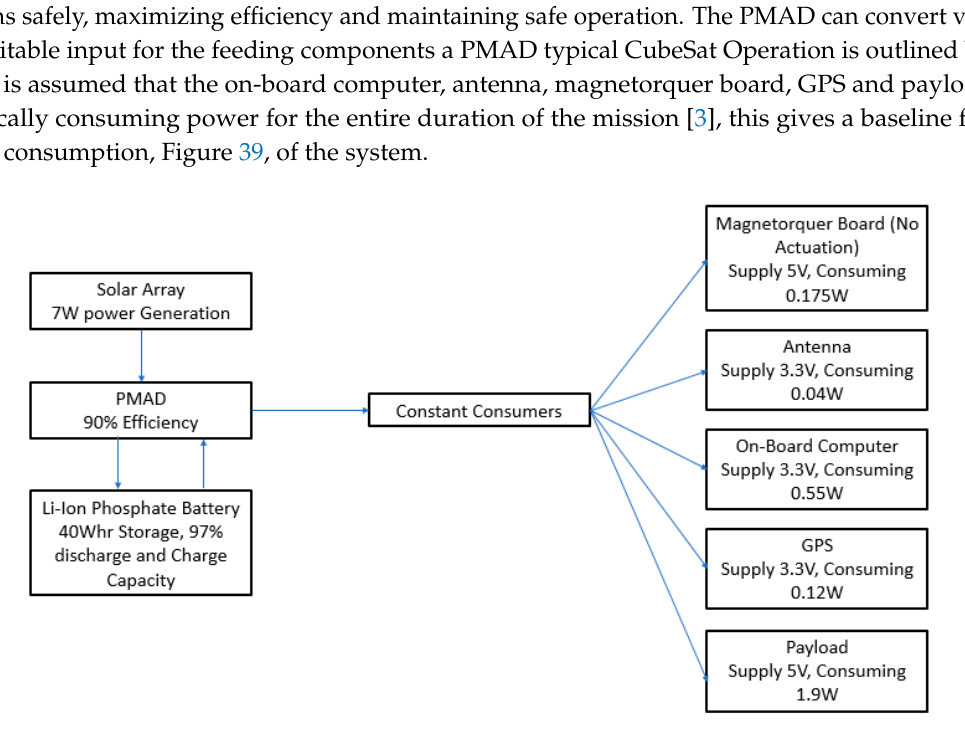
Figure 39. Baseline Power Draw of the CubeSat Electrical System Hot Phase.